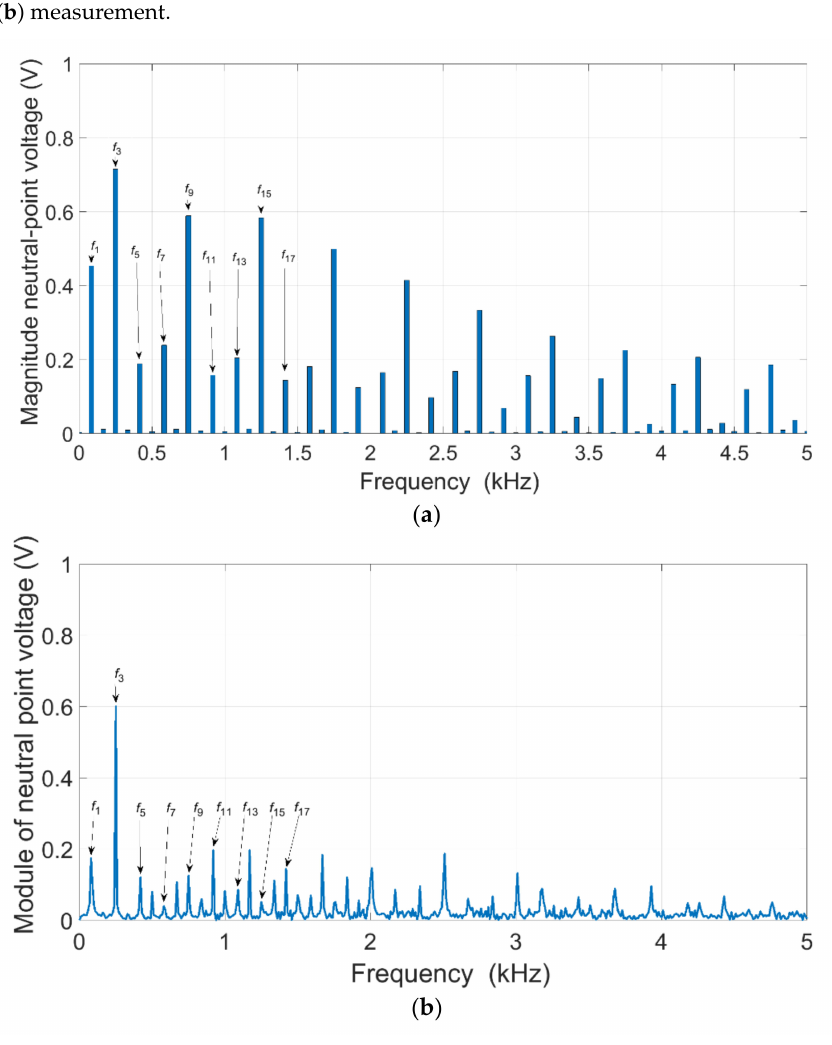
Figure 12. (cid:52) configuration—FFT of neutral voltage—SC2: ( a ) numerical calculations, ( b )